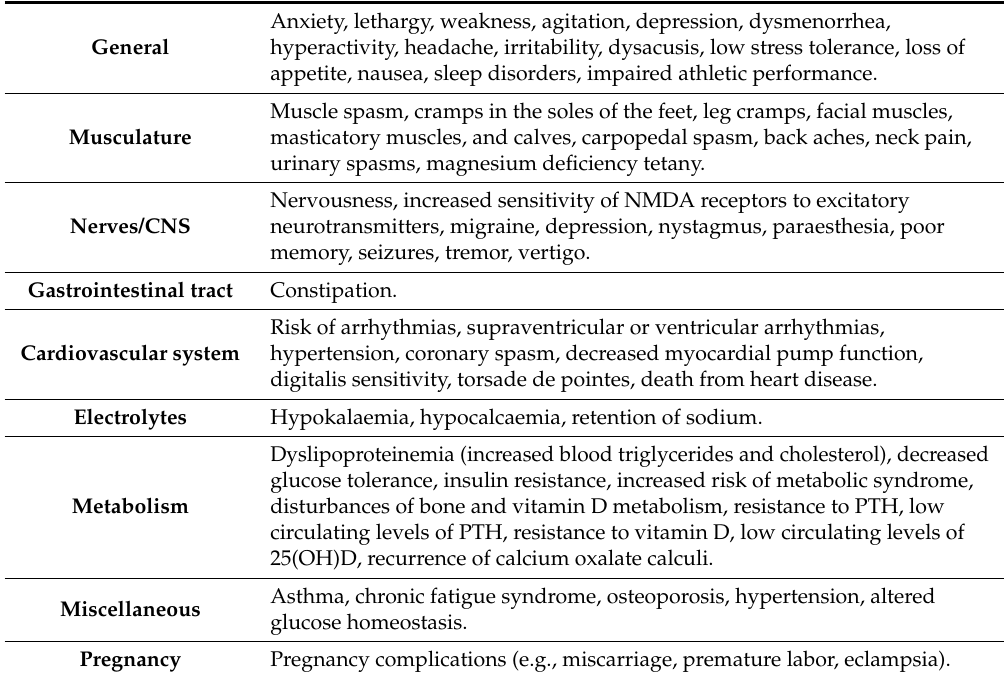
Table 1. Magnesium: Deficiency signs and symptoms